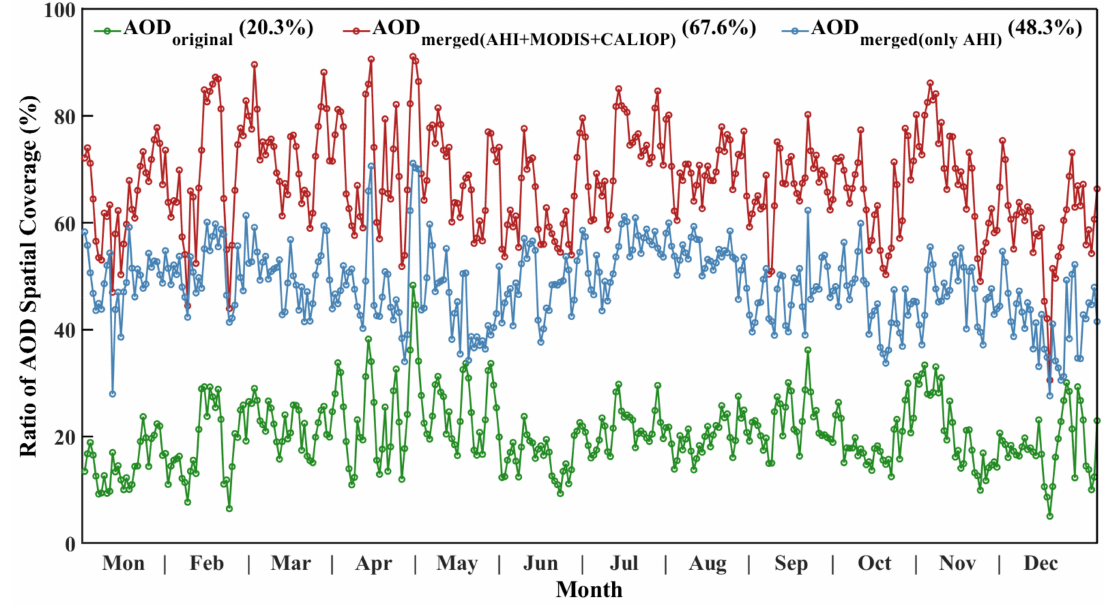
Figure 5. Daily averaged AOD spatial completeness ratio in 2017 for the original Himawari-8 AHI AOD (green), merged AOD blending AHI, MODIS, and CALIOP AOD based on GL-BME (red) and merged AOD via only AHI AOD based on BME (blue).